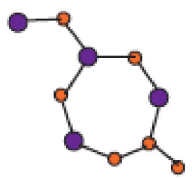
Figure 1: Unit cell of Si